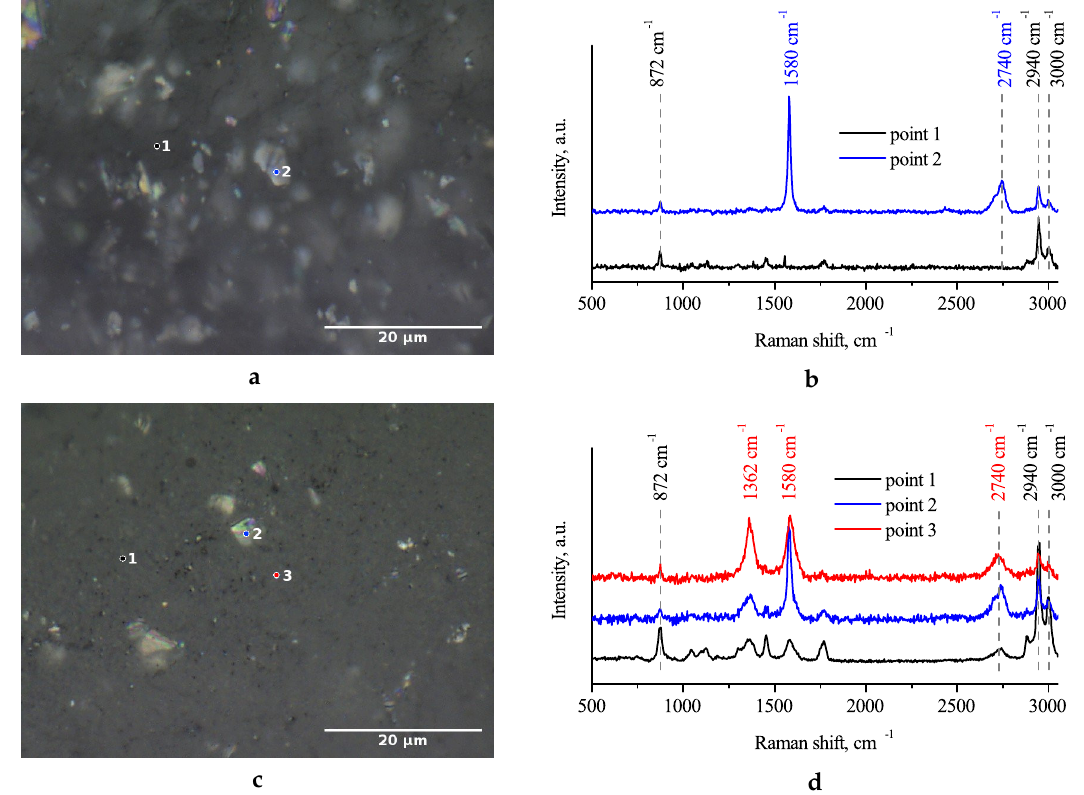
Figure 1. Optical microscopy image ( a ) and Raman spectra ( b ) of PLA composite containing 1.5% GNP. Due to the neat PLA transparency, it is possible to see GNPs under the surface of a composite. Optical microscopy image ( c ) and Raman spectra ( d ) of PLA composite containing the mixture of 3% GNP and 3% MWCNT. Raman spectrum collected at point 2 combines the characteristic peaks of PLA, GNPs, and